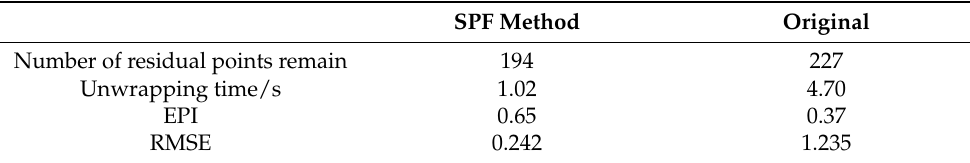
Table 3. The quantitative evaluation of the results before and after using the SPF method.